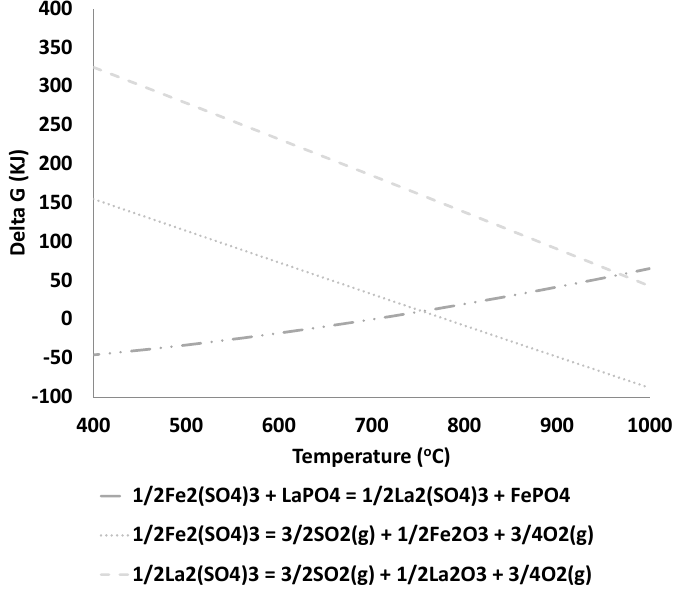
Figure 4. Free energy (Delta G— Δ G) of Equations (5–7) (kJ) from 400 °C to 1000 °C.